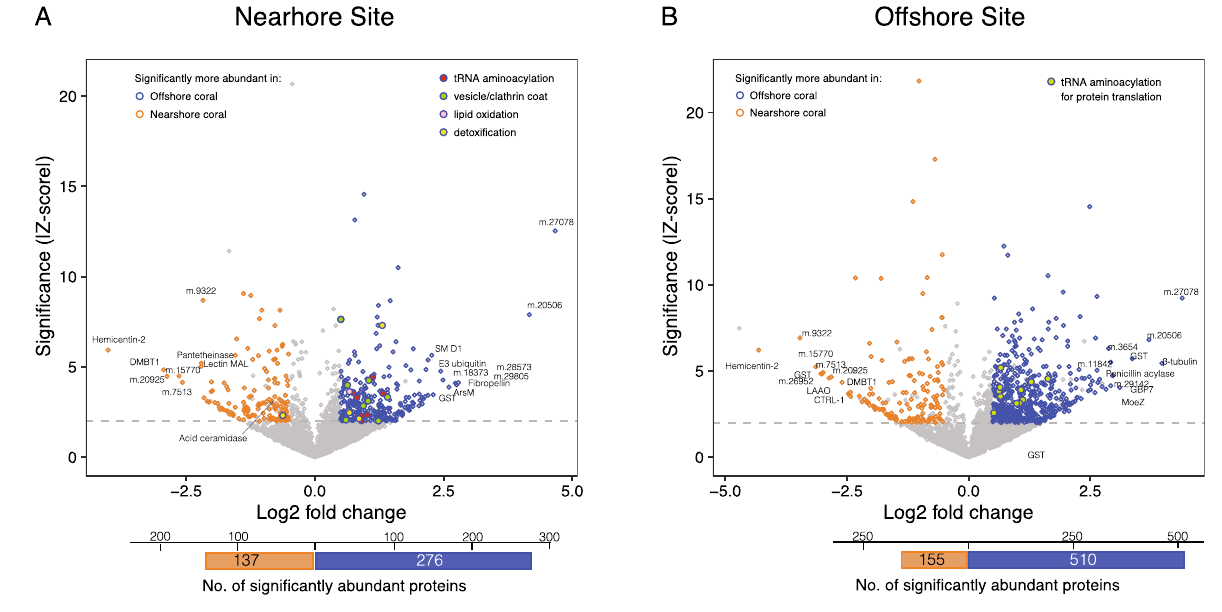
Figure 3. Protein abundance comparison between N- and O-corals. (A) At N-site, and (B) at O-site. Fold differences and Z-statistic values (Z-score) were used to generate volcano plots. Colored points indicate proteins with |fold|> 0.5, |Z-score|> 2 at FDR = 0.01. Proteins associated with key GO terms were colored in different colors, and the top 10 abundant proteins in each population are annotated. The bottom bars indicate the total numbers of significantly abundant proteins for each